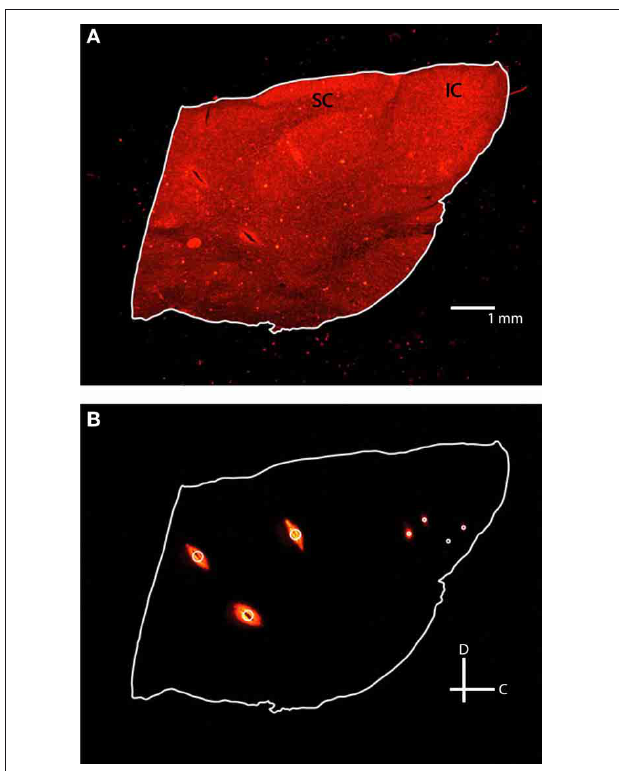
FIGURE 4 | Fluorescent images of the same 60 µ m thick sagittal slice with reflective white light (A) and fluorescence (B) settings. Each slice was outlined in white and three reference points (large white circle) and two pairs of electrodes (small white circles) were identified. IC, inferior colliculus; SC, superior colliculus; C, caudal; D,